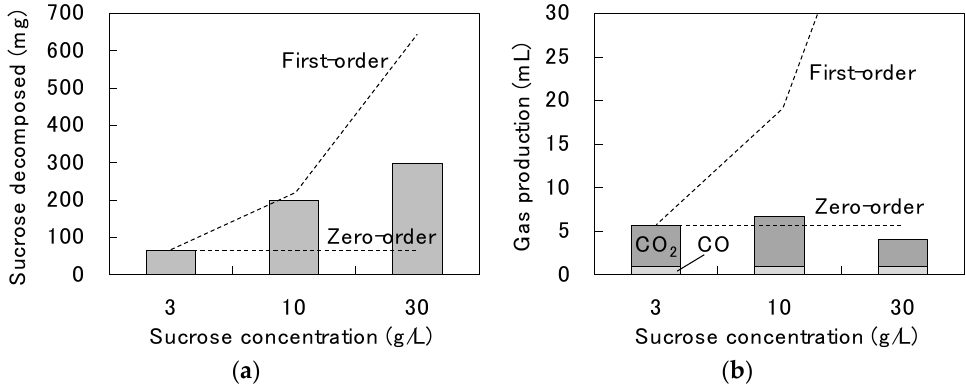
Figure 6. Effect of the sucrose concentration on the ( a ) amount of sucrose decomposed and ( b ) gas production in solution-plasma treatment of sucrose for 17 min with an electrode distance of 2.3 mm and circulation cooling with ice water.